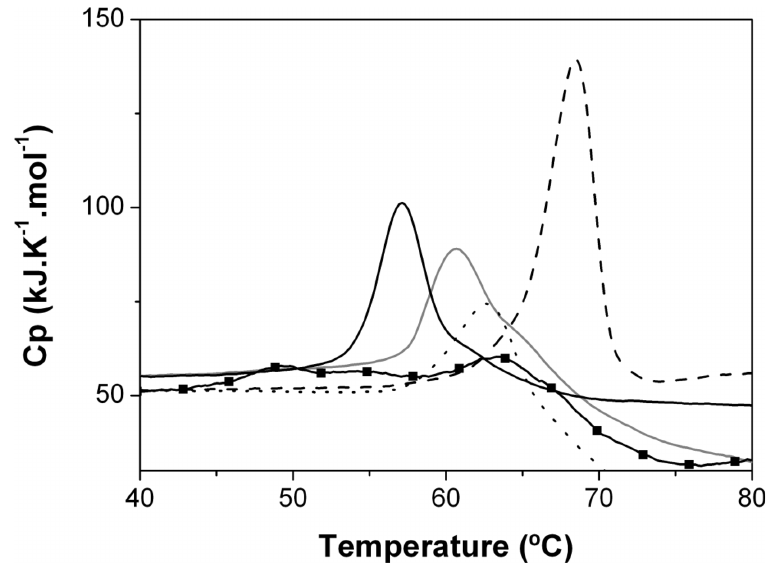
Fig 3. Thermal denaturation of TtgR WT and its variants in the absence of effectors, followed by Differential Scanning Calorimetry (DSC). TtgR WT (grey line), TtgR H114A (black solid line), TtgR N110A (black dashed line), TtgR E78A (black dotted line) and TtgR S77A (black squares and line).